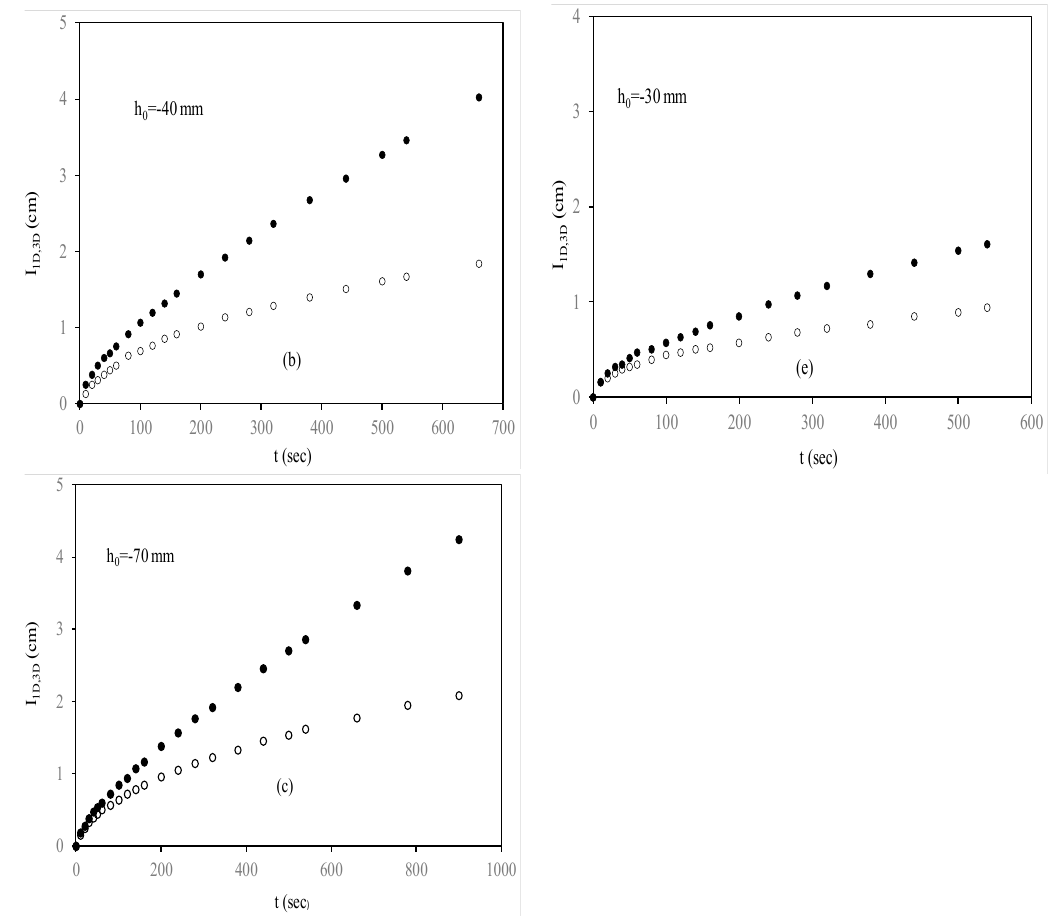
Figure 1. Representation of three- and one-dimensional experimental infiltration data with time, I 1D,3D (t), for various pressure heads: ( a ) h 0 = − 10 mm; ( b ) h 0 = − 40 mm; ( c ) h 0 = − 70 mm for Loam soil, and ( d ) h 0 = − 10 mm; ( e ) h 0 = − 30 mm for Silty Clay Loam soil. At short times (